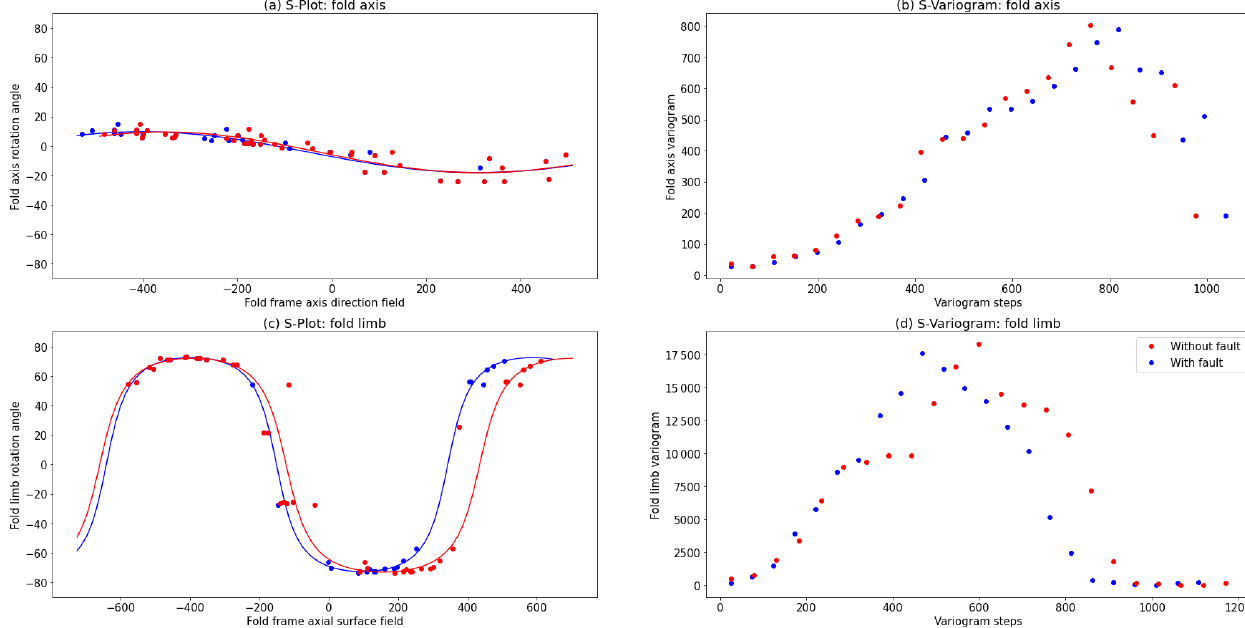
Figure 11. Fold geometry plots for the fold axis geometry and fold limb geometry. (a) S plot showing the variation in fold axis rotation angle with respect to the fold axis direction field showing the fold axis with and without the fault. (b) S variogram of the fold axis rotation angle. (c) S plot of the fold limb rotation angle with and without the fault. (d) S variogram of the fold limb rotation angle.